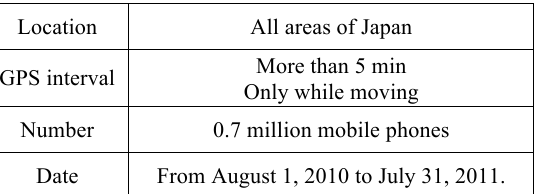
Table 1. Specification of